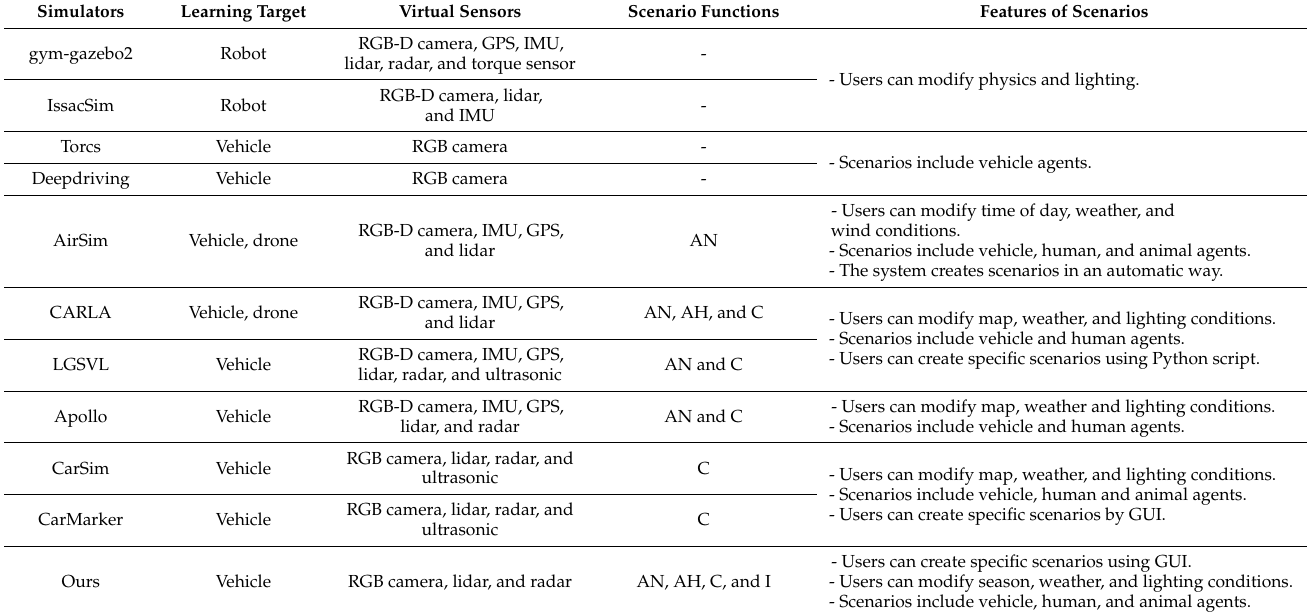
Table 1. Existing simulators. AN: automatic normal scenario; AH: automatic hazardous scenario; C: custom scenario; I: interrupt scenario; GUI: graphical user